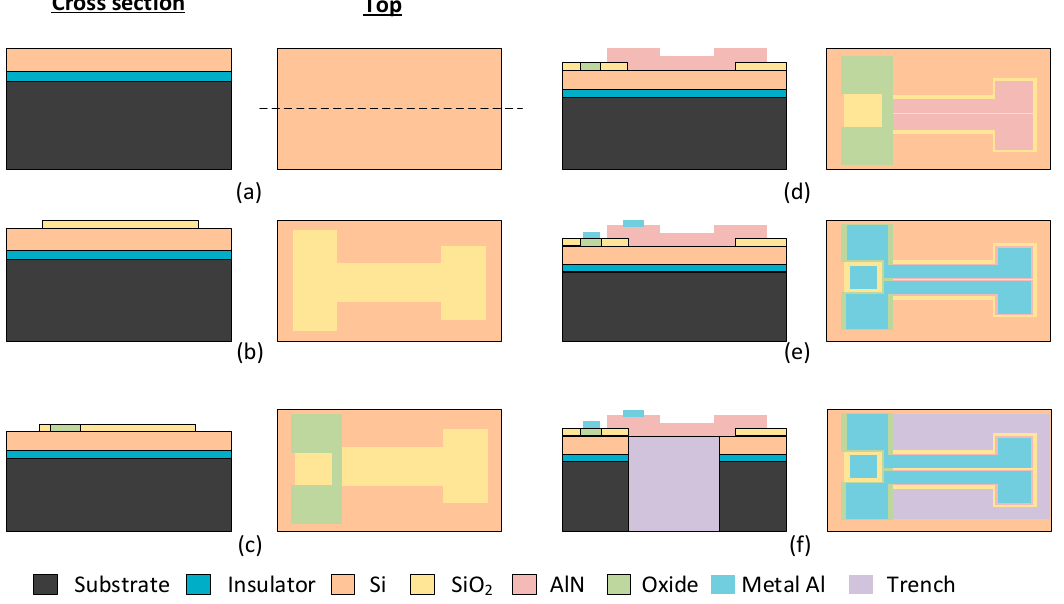
Figure 10. Overview of the processing steps of the PiezoMUMPs technology: ( a – f ) shows the process flow for the fabrication of a T-shape harvester.